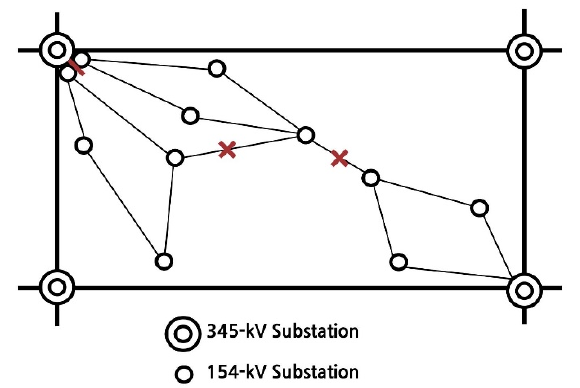
Figure 5. Bus and line separation method for reducing the short-circuit